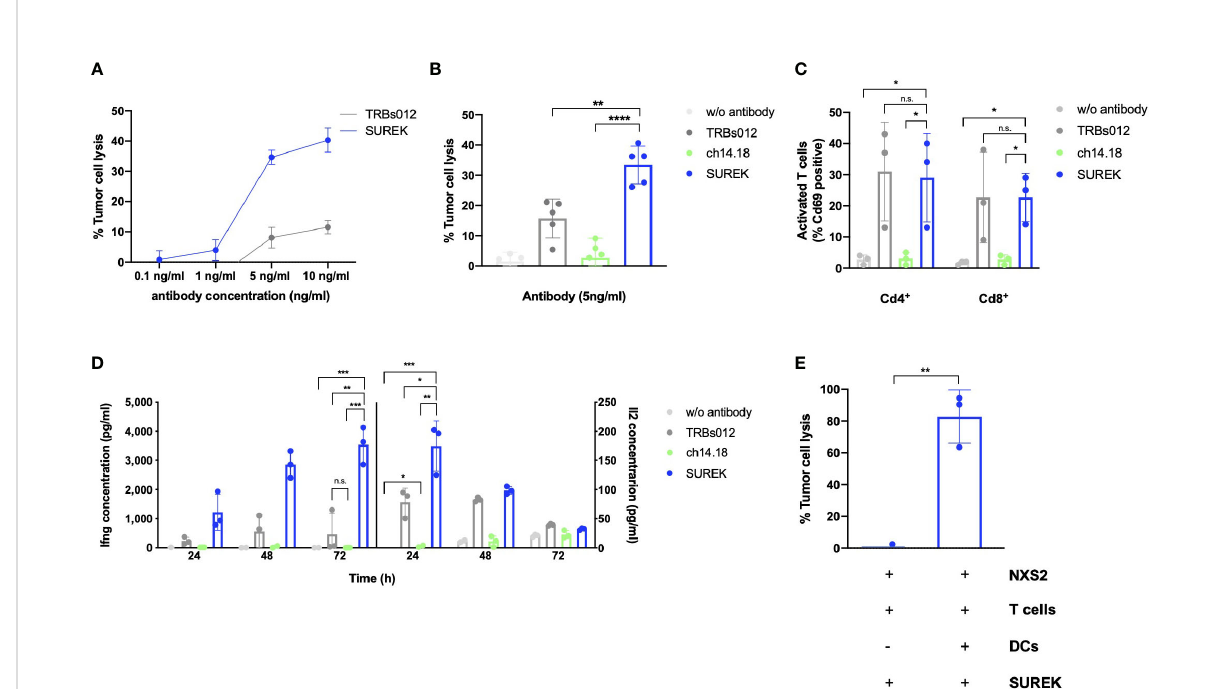
FIGURE 1 SUREK mediates a cytotoxic effect against the murine neuroblastoma cell line NXS2 dependent on T cells and dendritic cells. (A) The NXS2- GFP_f fl uc cells were co-cultivated with T cells (TC) and dendritic cells (DCs) (ratio 1:10:1). After co-cultured cells had been settled for 3 hours, they were treated with the bispeci fi c trifunctional antibodies (trAb) SUREK (GD2/Cd3) or TRBs012 (alphavirus E1/Cd3) in rising concentrations. Tumor cell lysis was determined by bioluminescent fl ux relative to an untreated co-culture after 72 hours (h). (B) NXS2-GFP_f fl uc cells were